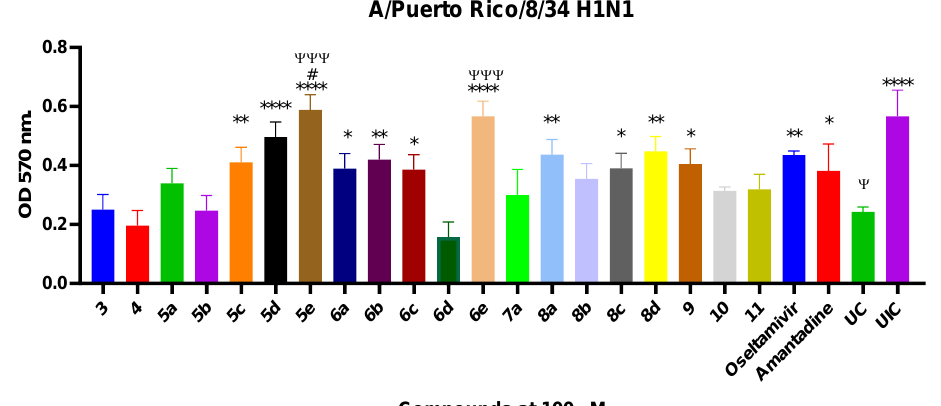
Figure 2. The in vitro antiviral activity of compounds 3 – 11 against the replication of influenza A/Puerto Rico/8/34 H1N1 strain in MDCK cells. MDCK cells were pretreated with compounds (100 µM) or antiviral control drugs (oseltamivir and amantadine) and infected with influenza A/Puerto Rico/8/34 H1N1 strain. After 24 h, the viability was measured using MTT assay. Uninfected control (UIC) cells were used as a comparison demonstrating the fully viable cells. * shows significant comparisons between test compounds and untreated control (UC), # shows significant comparisons between test compounds and oseltamivir, and Ψ shows significant comparisons between test compounds and amantadine. Statistical significance was tested with one-way ANOVA, and error bars show mean ± SD from three experiments. * p < 0.05, ** p < 0.0021, **** p < 0.0001, ΨΨΨ p < 0.0001.